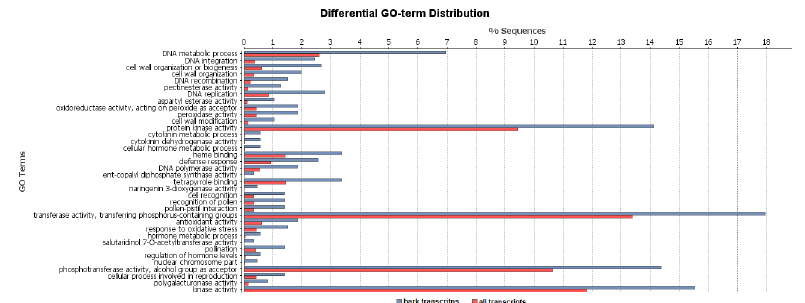
Figure 4. GO enrichment analysis for the bark-exclusive transcripts.